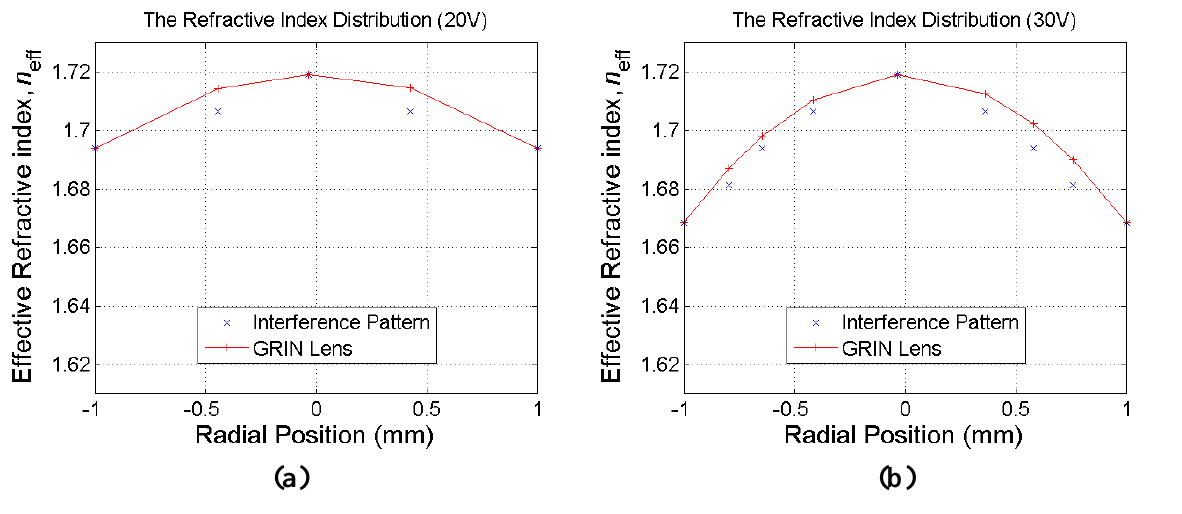
Figure 7. Extracted indices and focus lengths with 20 V, 30 V, 40 V and 50 V applied to the ring